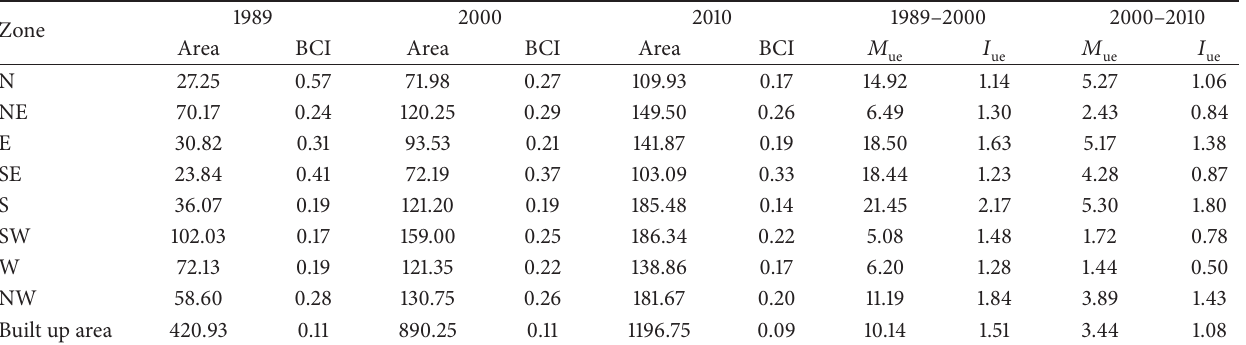
Table 2: The characteristics of urban land expansion in Beijing during 1989–2010 (unit: area-km 2 ).